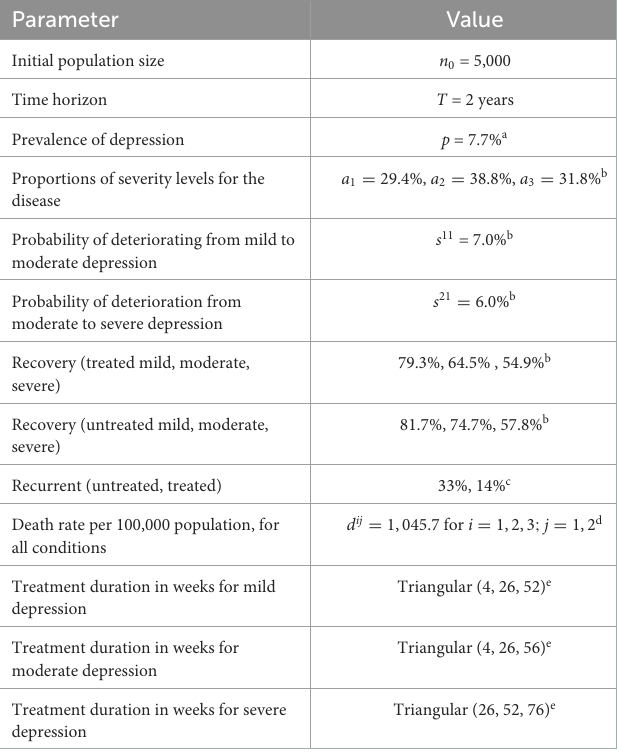
a Est.usingdepressionregistersandmid-populationestimatesforadults(76,77). b AdaptedfromTable2inSimonetal.(78). c Source(79). d